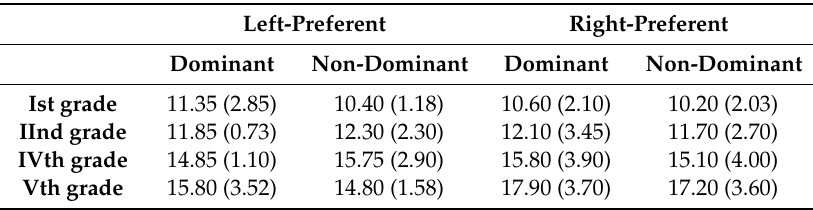
Table 1. Overview of results of the handgrip strength ( HS ) test stratified by school grade and hand preference. Higher values denote better results.